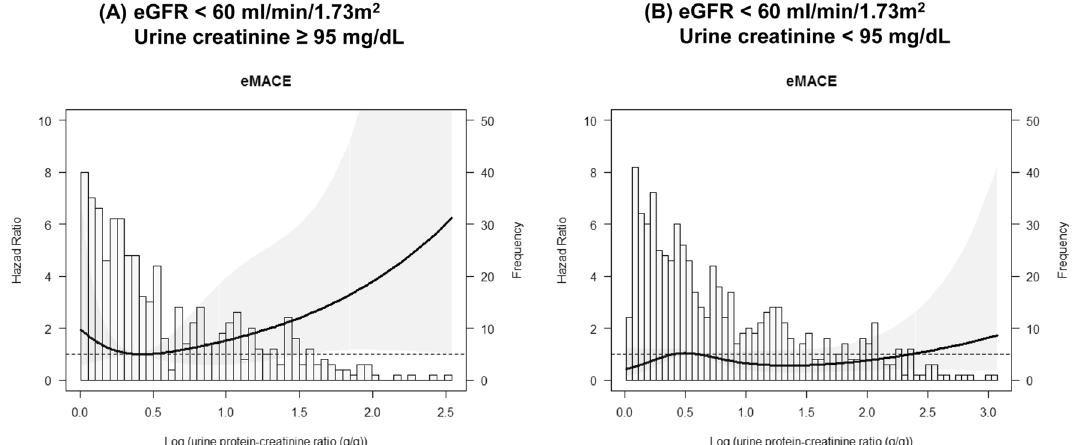
Figure 3. Adjusted risk for extended major adverse cardiovascular events (eMACEs) according to urine protein–creatinine ratio (UPCR) on a log scale in patients with estimated glomerular filtration rate (eGFR) < 60 mL/min/1.73 m 2 stratified by urine creatinine concentration. Spline curves showing the adjusted hazard ratios of eMACEs in patients with urine creatinine concentration ≥ 95 ( A ) and < 95 mg/dL ( B ). These ratios were adjusted for age; sex; body mass index; smoking status; presence of diabetes, hypertension, glomerulonephritis, and previous cardiovascular disease; baseline eGFR; and use of renin–angiotensin– aldosterone system blocker and statins. The histograms show the frequency of distribution of spot